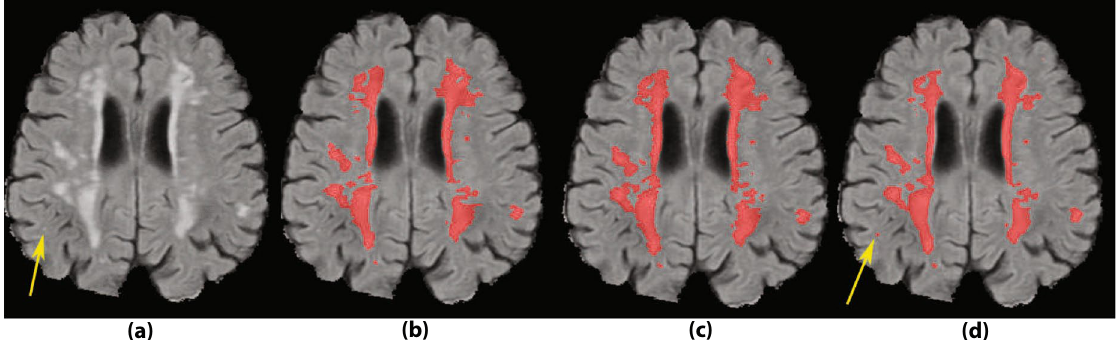
Figure 8. A sample case with a small lesion missed by the two human observers. ( a ) FLAIR image without annotations. ( b ) Segmentation by human observer 1. ( c ) Segmentation by human observer 2. ( d ) Segmentation by MSWS + Loc